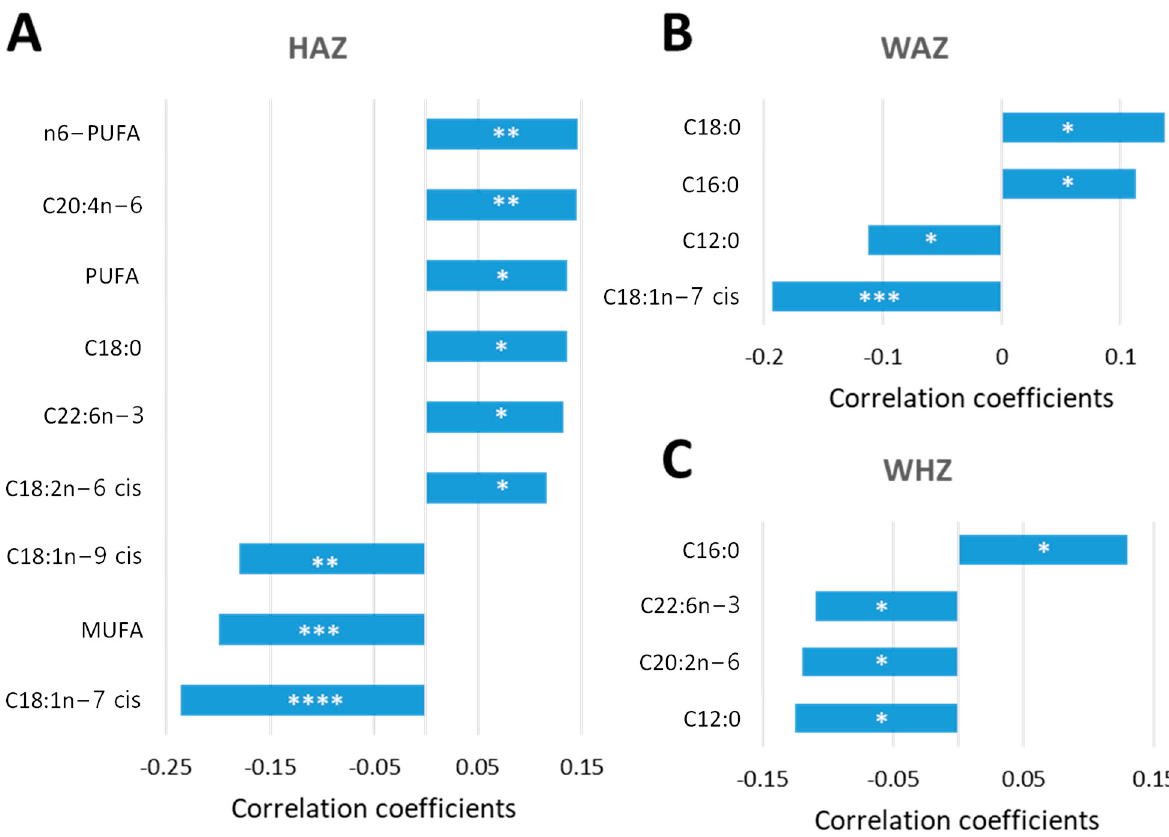
Figure 6. NEFA biomarkers as predictors of long-term growth outcome. Percentages of NEFAs at 9 months of age (data set consisted of 322 Pakistani children) were correlated with HAZ ( A ), WAZ ( B ) and WHZ ( C ) scores at 24 months using a pattern search and Pearson’s r as distant measure. Significant linear correlations are considered when the p -value was lower than 0.05. * p < 0.05, ** p < 0.01, *** p < 0.001, **** p < 0.0001.